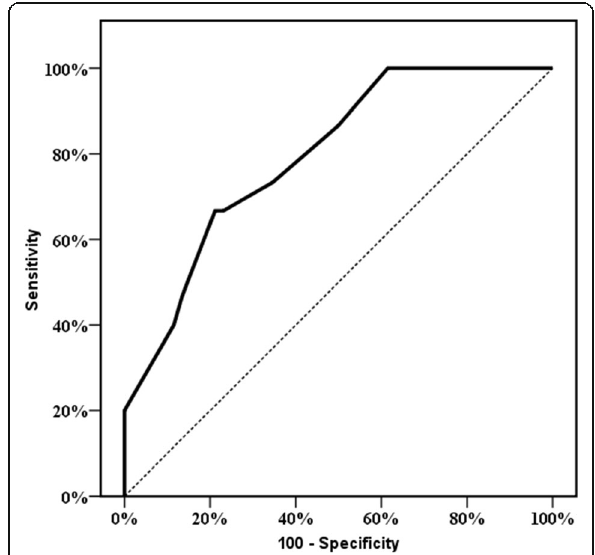
Fig. 6 ROC curve to assess agreement (sensitivity, specificity) of the ADC value to diagnose cases with papillary RCC from other cases (neoplastic and non-neoplastic). Cutoff ADC value of ≤ 1 × 10 − 3 mm 2 /s to diagnose cases with papillary RCC from other cases can be used with a sensitivity of 88.24% and specificity of 49.15%